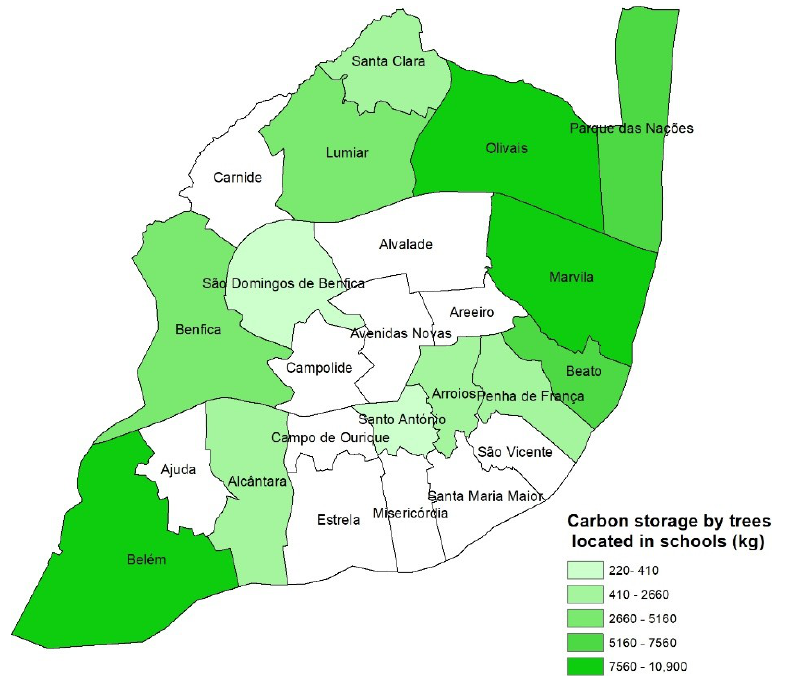
Figure 9. Carbon storage by trees located in schools for each parish of the city of Lisbon.